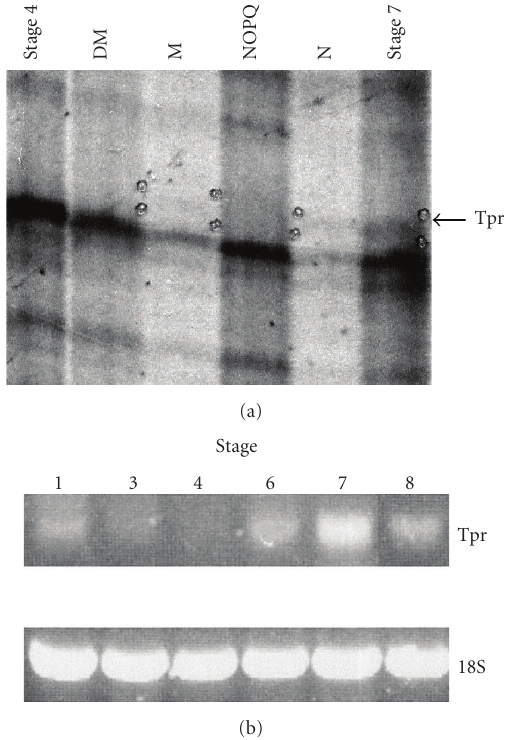
Figure 2: Di ff erential expression of Tpr during leech embryo- genesis. (a) Di ff erential display analysis shows faint Tpr bands (boxed with pinholes) in teloblast lanes M and N, and in stage 7 embryos which contain teloblasts M, N, O, P and Q. Bands above and below appear in all lanes and are likely “housekeeping” genes. (b) Semi-quantitative RT-PCR analysis shows declining Tpr transcripts during stage 1 (presumably maternal) through stage 4; accumulation of new zygotic transcripts was evident thereafter and peaked at stage 7. Lanes were normalized with 18S rRNA